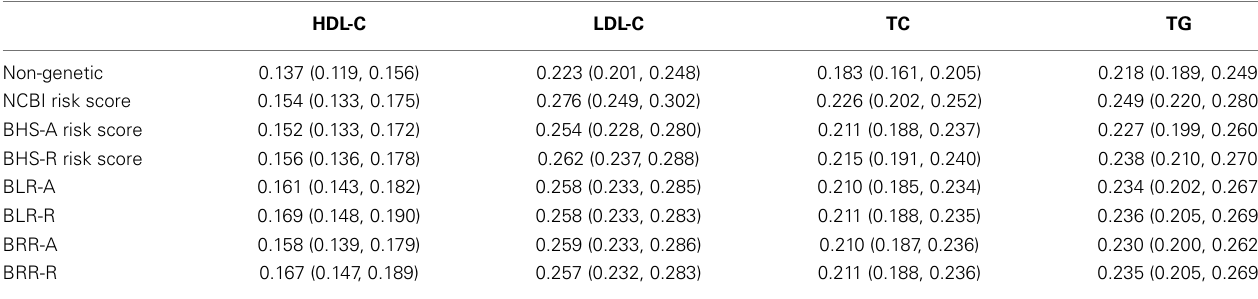
Table 2 | Predictive accuracy, measured as the square of the Pearson’s correlation between observed and predicted outcomes.